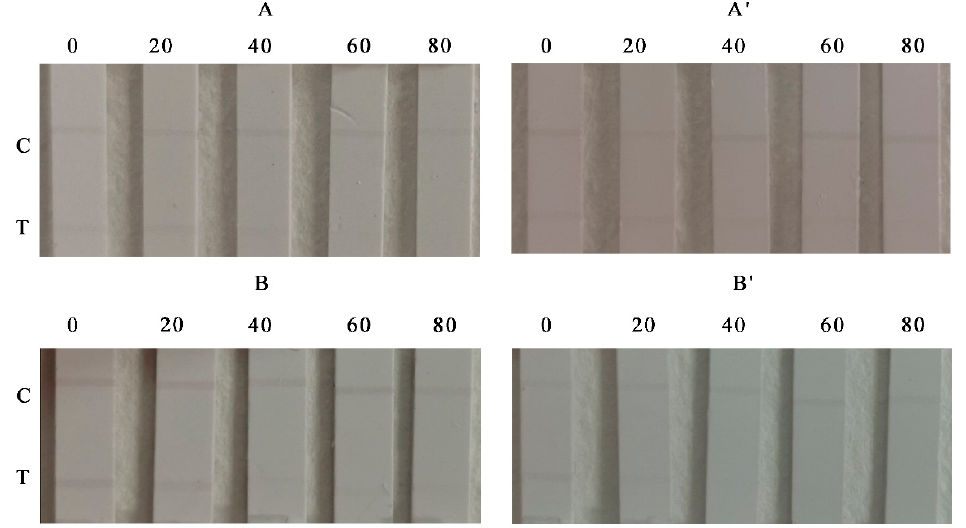
Figure 4. Results of ZEN detection in spiked cereal samples using AuSP-ICA ( A : corn; B : wheat) and AuNRs-ICA ( A’ : corn; B’ : wheat) strips. Spiked ZEN concentrations in cereal samples: 0, 20, 40, 60, and 80 μ g kg − 1 .